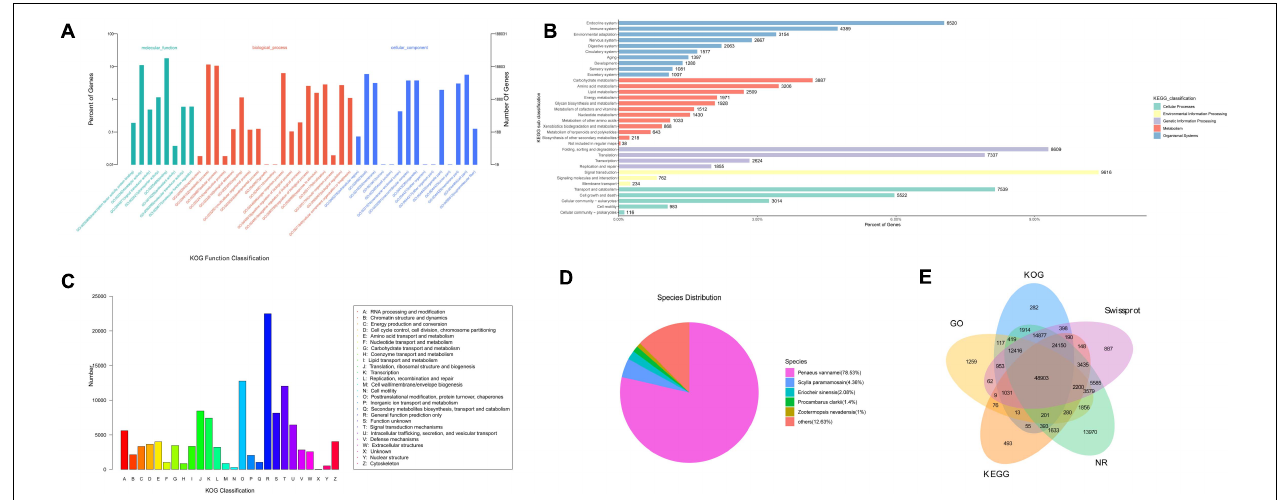
FIGURE 2 | Functional classification of novel transcripts of Scylla paramamosain . (A) Gene ontology (GO) annotation; (B) KEGG pathway classification; (C) KOG classification; (D) Species distribution of NR annotation; and (E) overall results of annotation on GO, KEGG, NR, Swissprot, and KOG databases. The number represents novel genes identified in NR, KOG, KO, Swissprot, and GO databases.